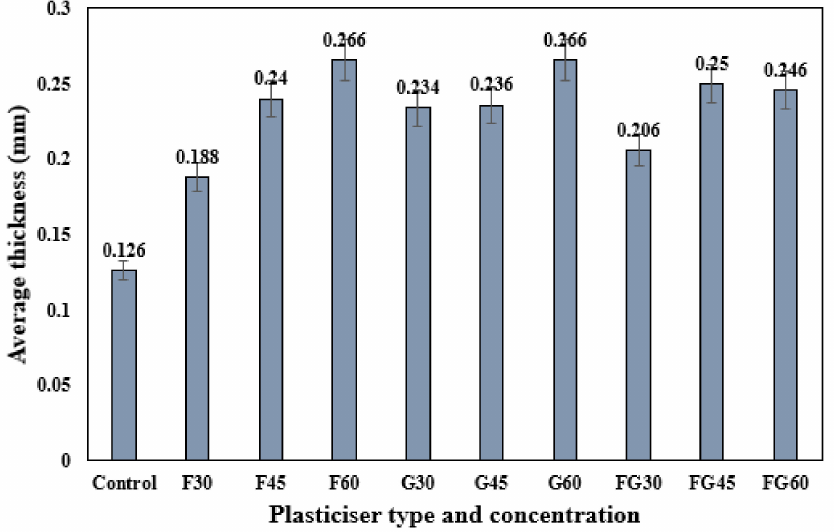
Figure 2. Thickness of corn starch films with various plasticizer types at different concentrations.